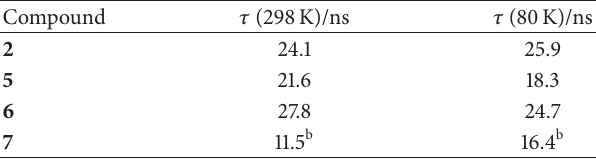
Table 2: Emission lifetime data on repeat unit 2 and polymers 5 – 7 a